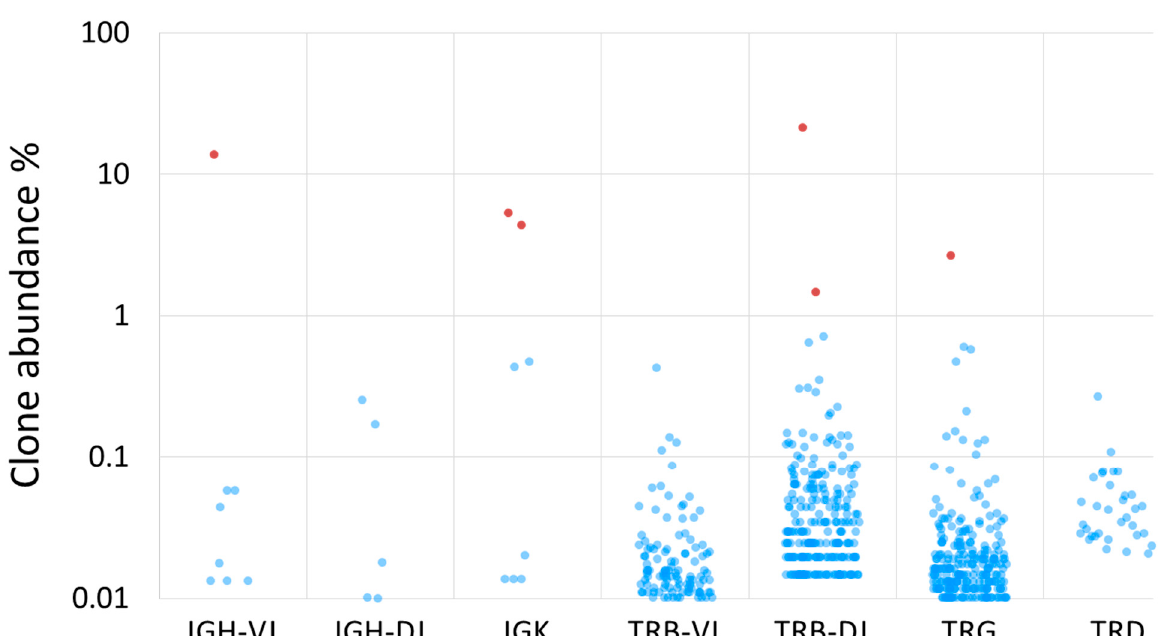
Figure 2. Normalized abundances of IG/TR clones in the diagnostic sample of a patient with B-cell precursor ALL. The sample was analysed using the EuroClonality-NGS assays [99]. Clone abundances were normalized using the EuroClonality-NGS spike-in controls [107]. Clones with an abundance <0.01% are not shown. Leukemia-associated clones which can be used for MRD-detection are shown as red dots, background physiological rearrangements as blue dots.